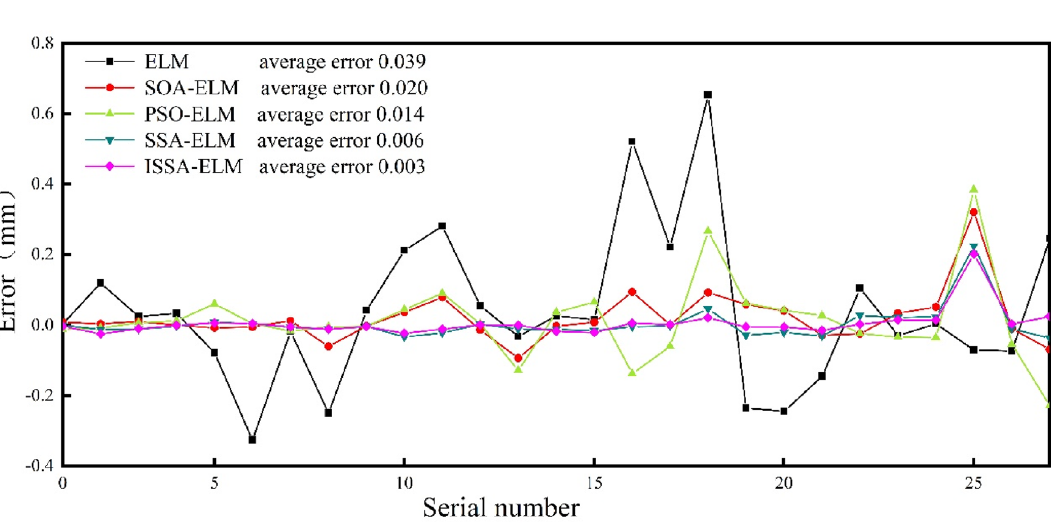
Figure 8. Comparing the prediction errors of different